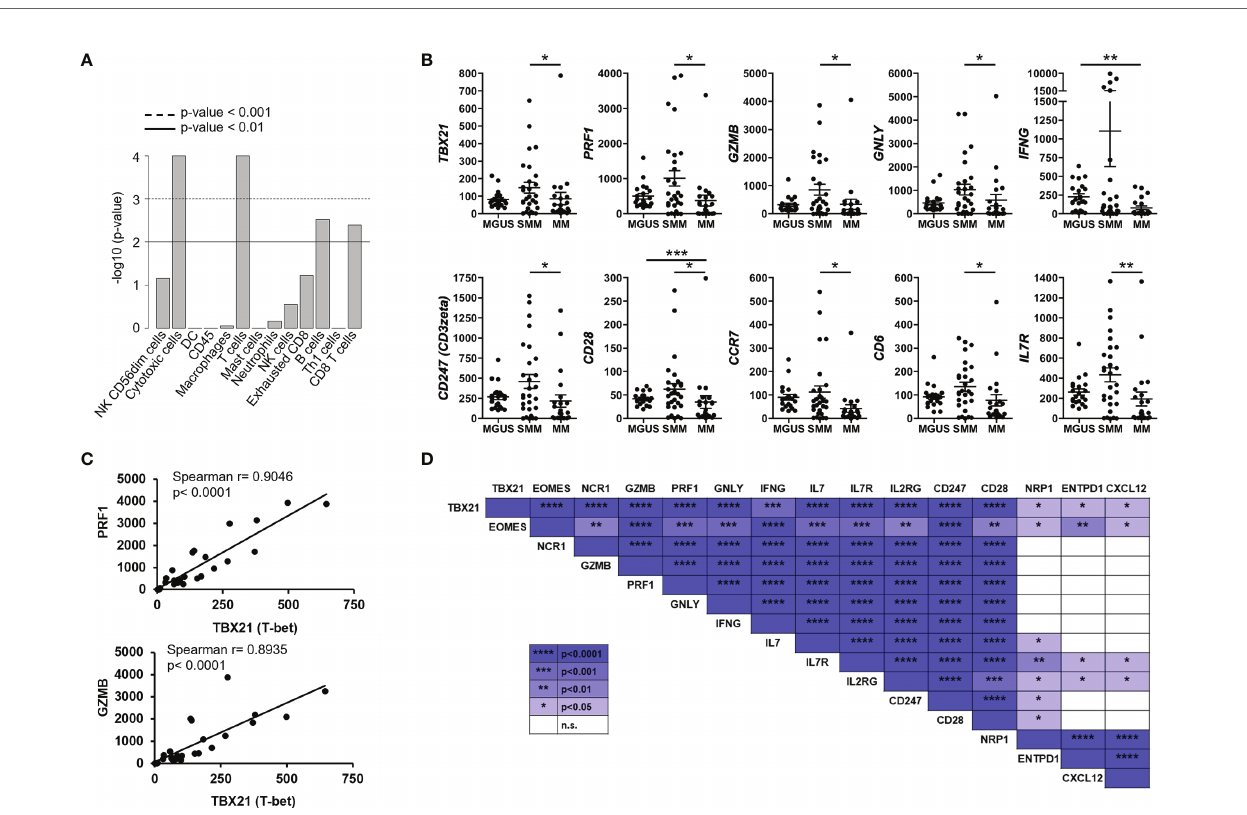
FIGURE 3 | Highly expressed genes associated with cytotoxic T cell function correlated with transcription factors Tbet and Eomes in SMM. (A) Statistical analysis of cell types involved in SMM compared to MM. (B) Gene expression of genes signi fi cantly upregulated in patients with SMM. Kruskal Wallis test *p<0.05, **p<0.01, ***p<0.001. (C) Positive correlation between transcription factor Tbet ( TBX21 ) and both perforin ( PRF1 ) and granzyme b ( GZMB ). Spearman r and p values are indicated. (D) Summary of correlation analyses in gene expression in patients with